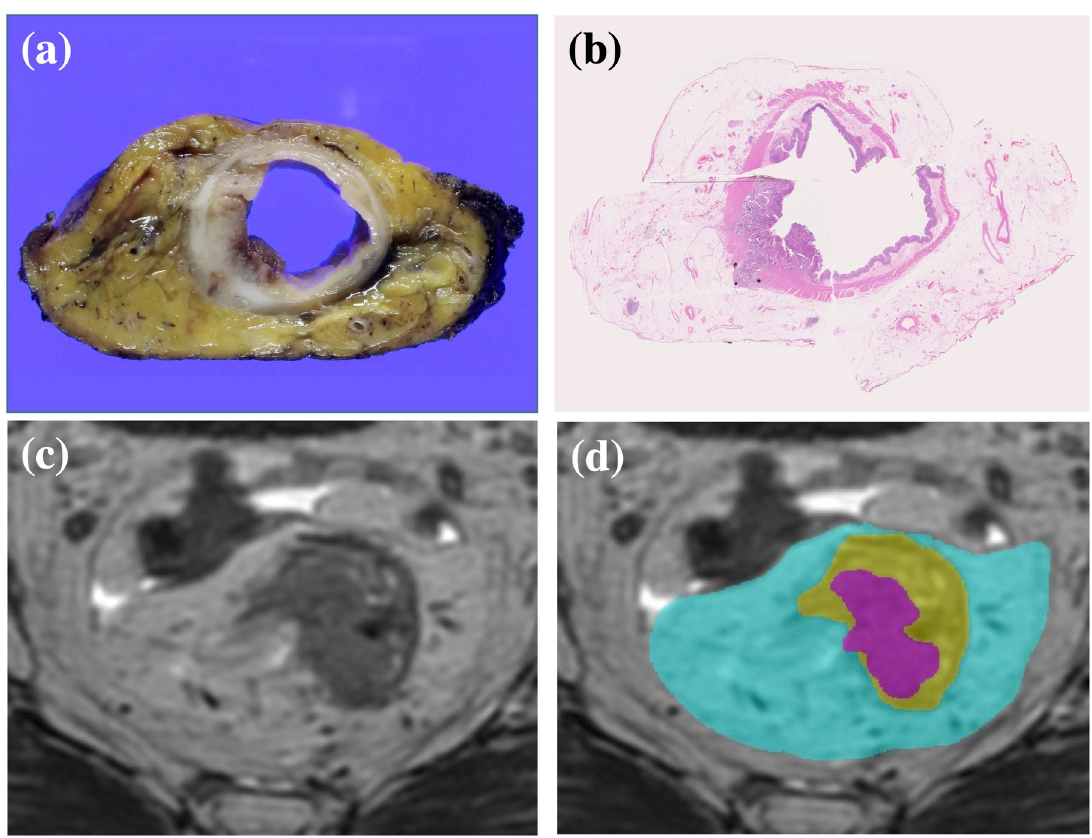
Fig 2. Preparation for ground-truth segmentation labels. (a) Section of a circular specimen. (b) Pathological section of the specimen stained with hematoxylin-eosin revealing areas of tumor, rectum, and mesorectum. (c) Axial MR image of the rectal cancer. (d) Ground- truth segmentation labels were used to annotate the MR images. The areas colored magenta, yellow, and cyan represent tumor, rectum, and mesorectum,